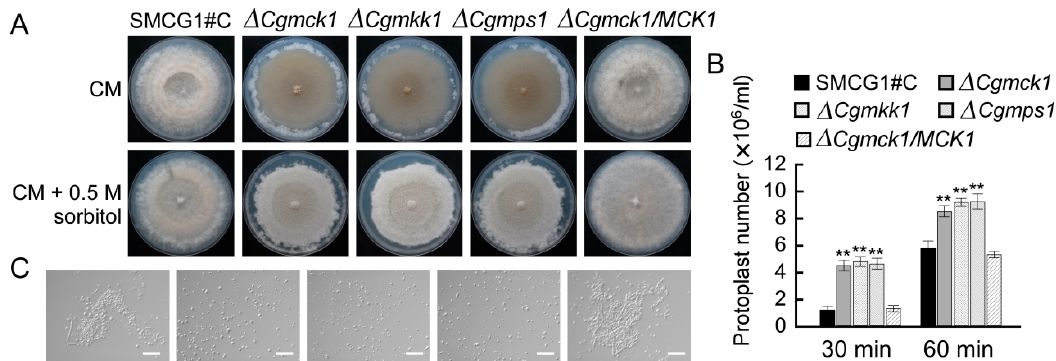
Figure 3. The ∆ Cgmck1 mutants showing defects in cell wall integrity. ( A ) Hyphal autolysis of the ∆ Cgmck1 , ∆ Cgmkk1 , ∆ Cgmps1 mutants observed on CM medium for 14 days post inoculation. ( B ) Protoplasts concentration at 30 min and 60 min after the mycelia was treated by wall cell-degrading enzyme. Error bars represent the SD, and asterisks indicate statistically significant differences ( p < 0.01). ( C ) Protoplast production by cell wall degrading enzyme. Photographs were taken at 60 min post inoculation. Bars = 50 µm.